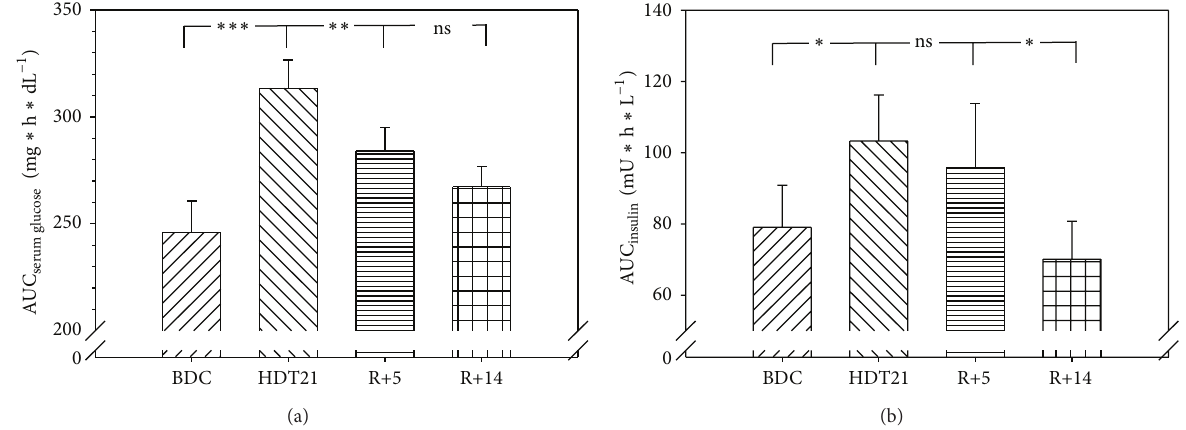
Figure 2: (a) Area under the curve (AUC) of glucose concentrations (mean values (SEM)) after 120min following an oral glucose tolerance test during the in-house ambulatory phase (BDC), after 20 days (day 21) in head-down tilt bed rest (HDT) and after 4 (R+5, in-house) and 13 (R+14) days of recovery. NS: not significant. ∗ 𝑃 < 0.05 ; ∗∗ 𝑃 < 0.01 . (b) Mean values and SEM of the AUC of serum insulin concentrations (mean values (SEM)) after 120min following an oral glucose tolerance test on the identical days as glucose concentration was analyzed. NS: not significant. ∗ 𝑃 < 0.05 ; ∗∗ 𝑃 < 0.01 ; ∗∗∗ 𝑃 < 0.001 .